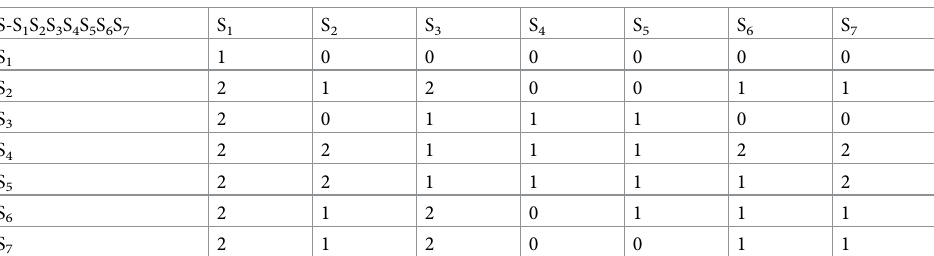
Table 5. State comparison matrix.